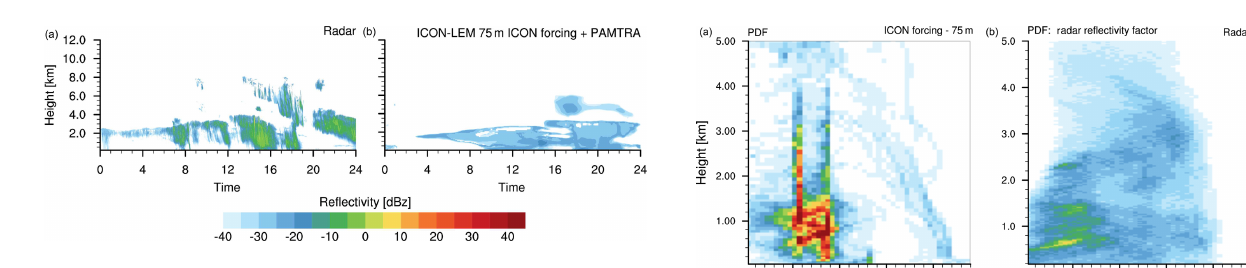
Figure 5. Time series of observed (a) and simulated cloud radar reflectivity based on the ICON-LEM with 75m resolution (b) for the case study of 23 June 2017. Figure 6. 2-D histogram for simulated (a) and observed (b) radar